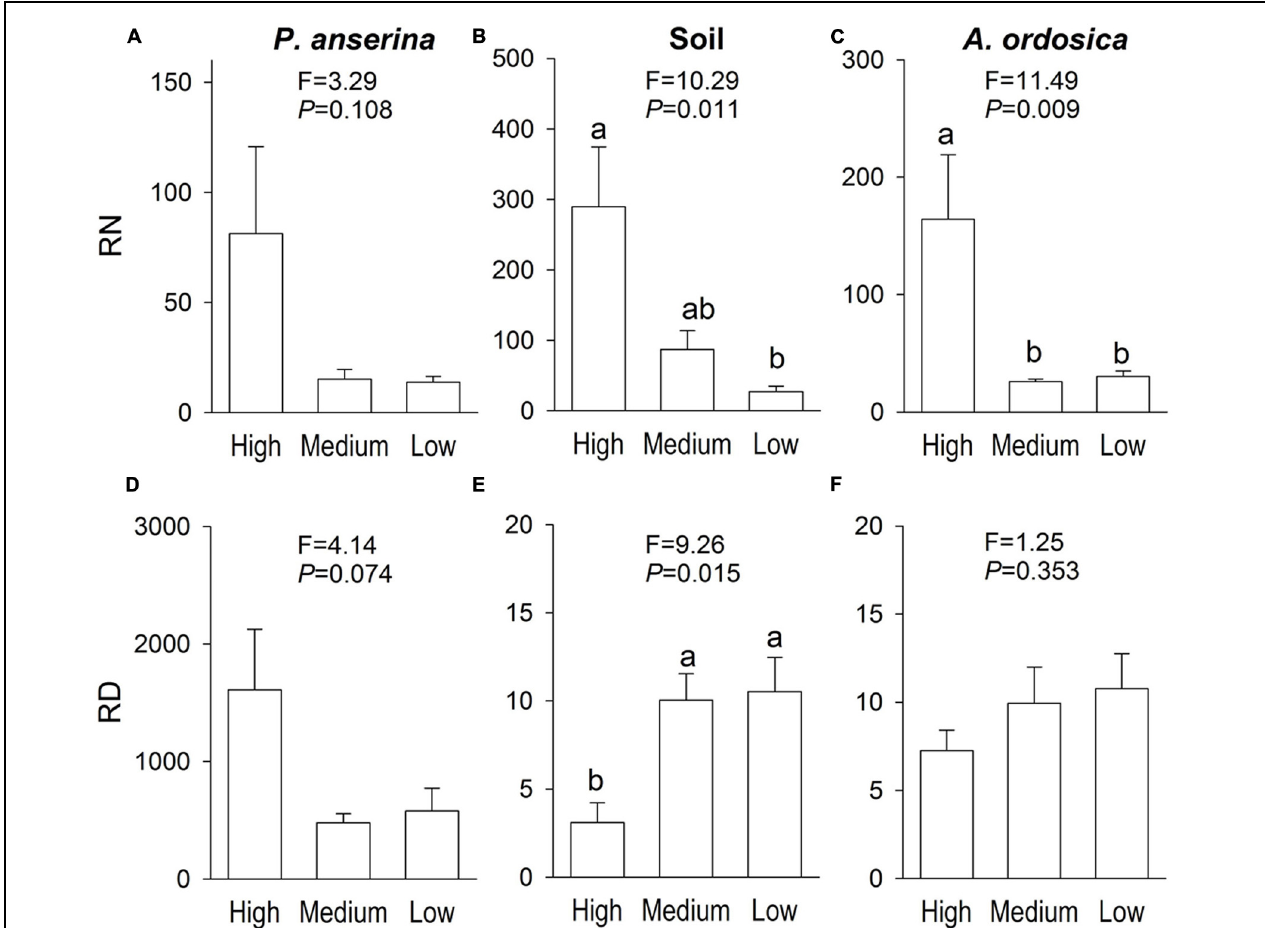
FIGURE 2 | The ratio of δ 15 N (RN, above, in Experiment I) and the ratio of δ D (RD, below, in Experiment II) in Potentilla anserina leaves (A,D), soils (B,E), and A. ordocia leaves (C,F) in the unlabeled, recipient containers with the high, medium and low water treatments that were connected to the P. anserina ramets with the high water supply. All means are significantly greater than 1 (one-sample t -tests). The F and P -values of the one-way ANOVA are also provided, and different letters indicate significant differences in means among treatments.